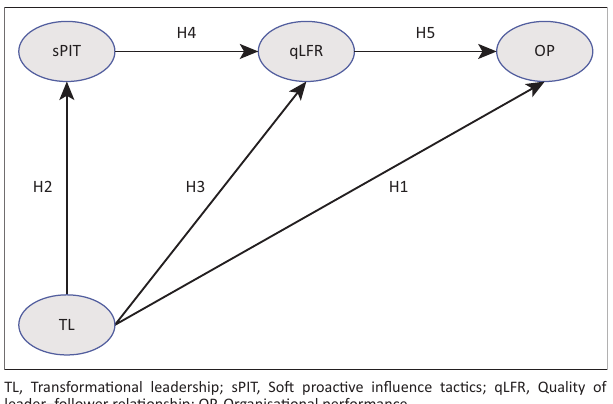
FIGURE 1: Proposed transformational leadership and organisational performance conceptual model